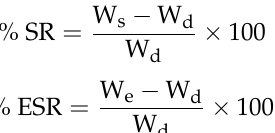
Table 1 lists the data for various